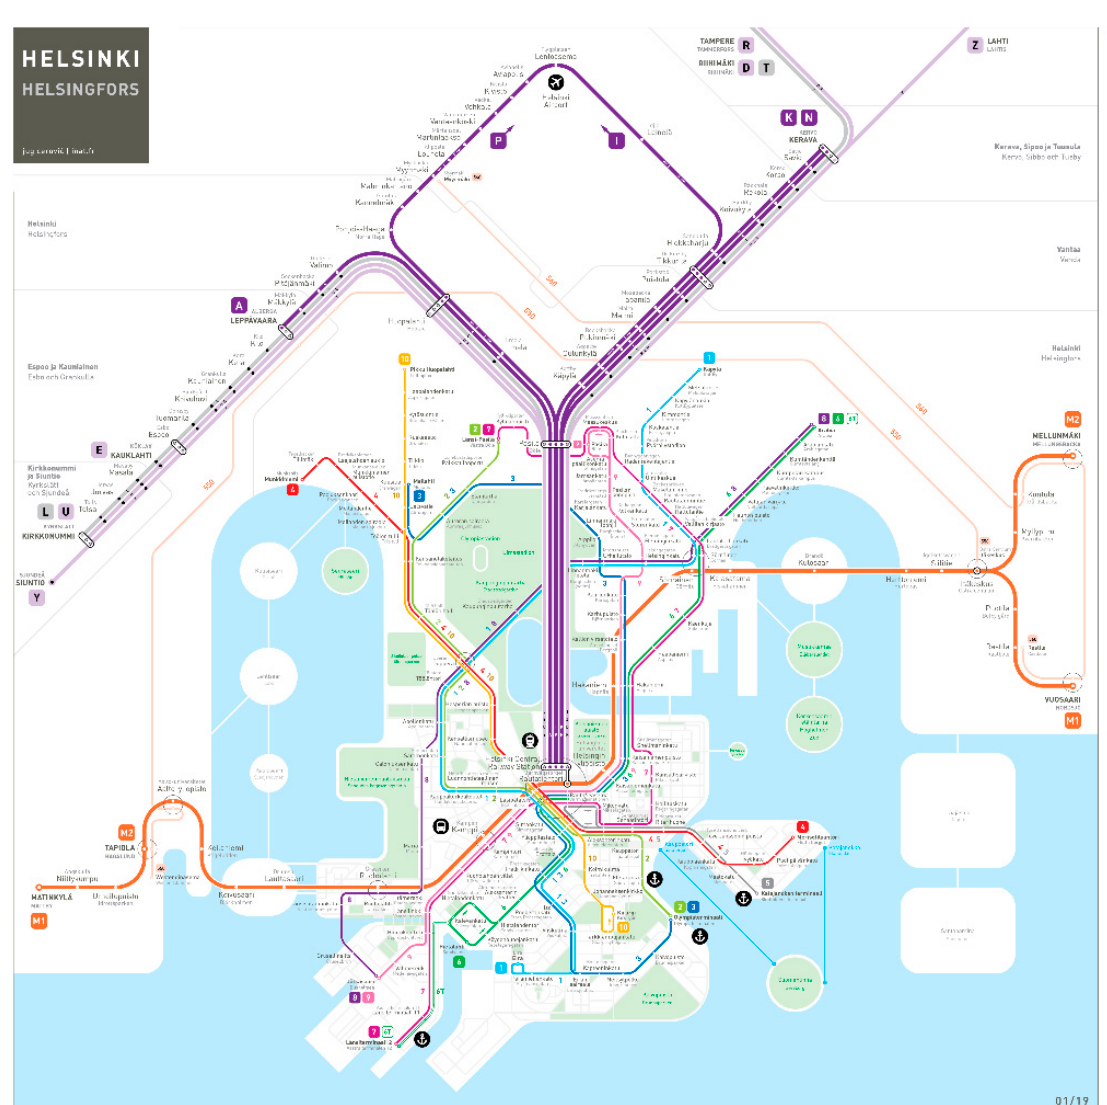
Figure 4. Helsinki Public Transport map.